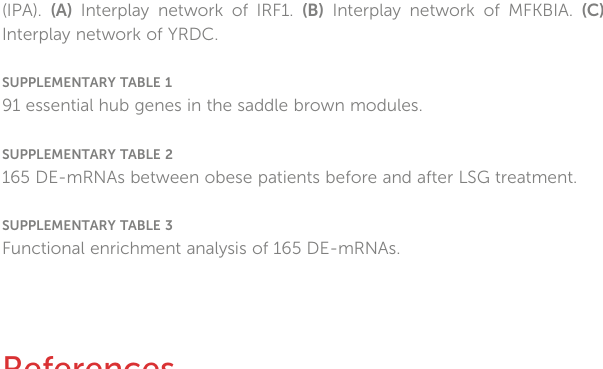
SUPPLEMENTARY FIGURE 2 Interplay network of three biomarkers through Ingenuity Pathway Analysis